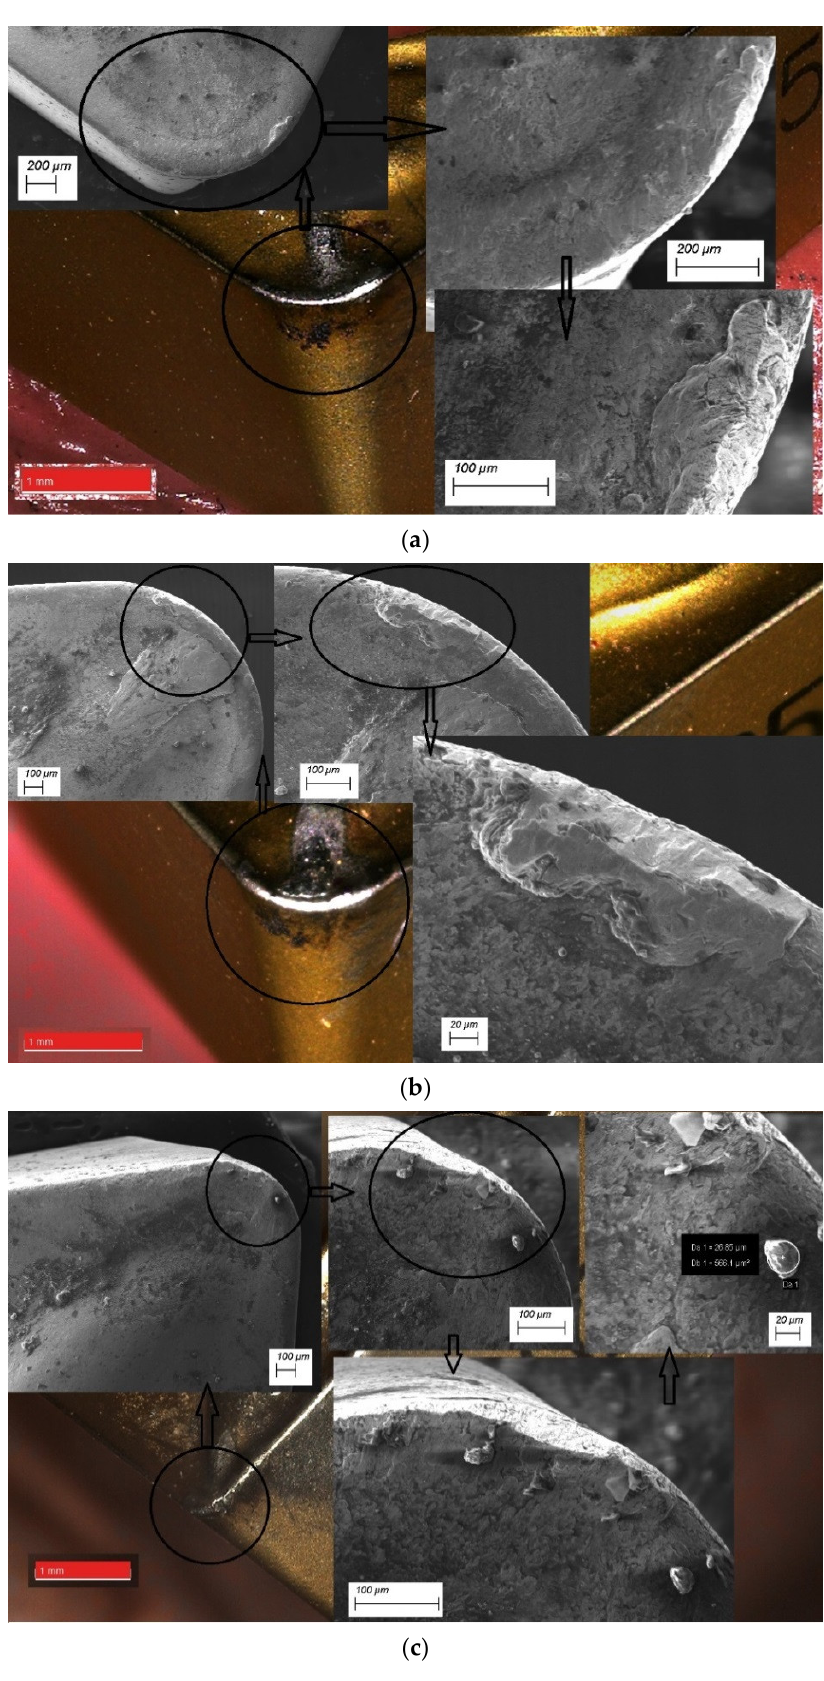
Figure 6. The detailed observation of tool wear for different types of inserts: ( a ) CC1; ( b ) CC2; ( c ) CC3.